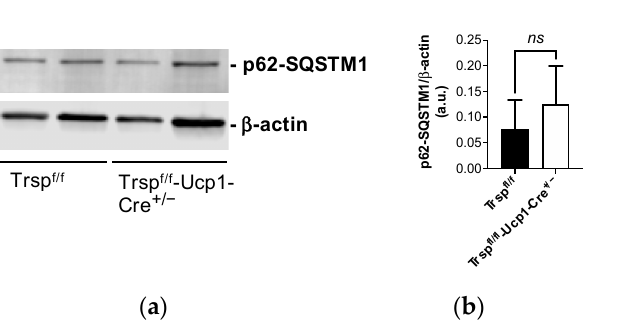
Figure 6. Autophagy in the cold-exposed male Trsp f/f -Ucp1-Cre +/ − mice. Levels of autophagy marker p62-SQSTM1 in the BAT of cold-exposed male Trsp f/f -Ucp1-Cre +/ − mice were obtained by ( a ) Western blot; ( b ) graph displays quantification analysis. Values are expressed as mean + SD, n = 11. Student’s unpaired t -test was performed; ns , non-significant.